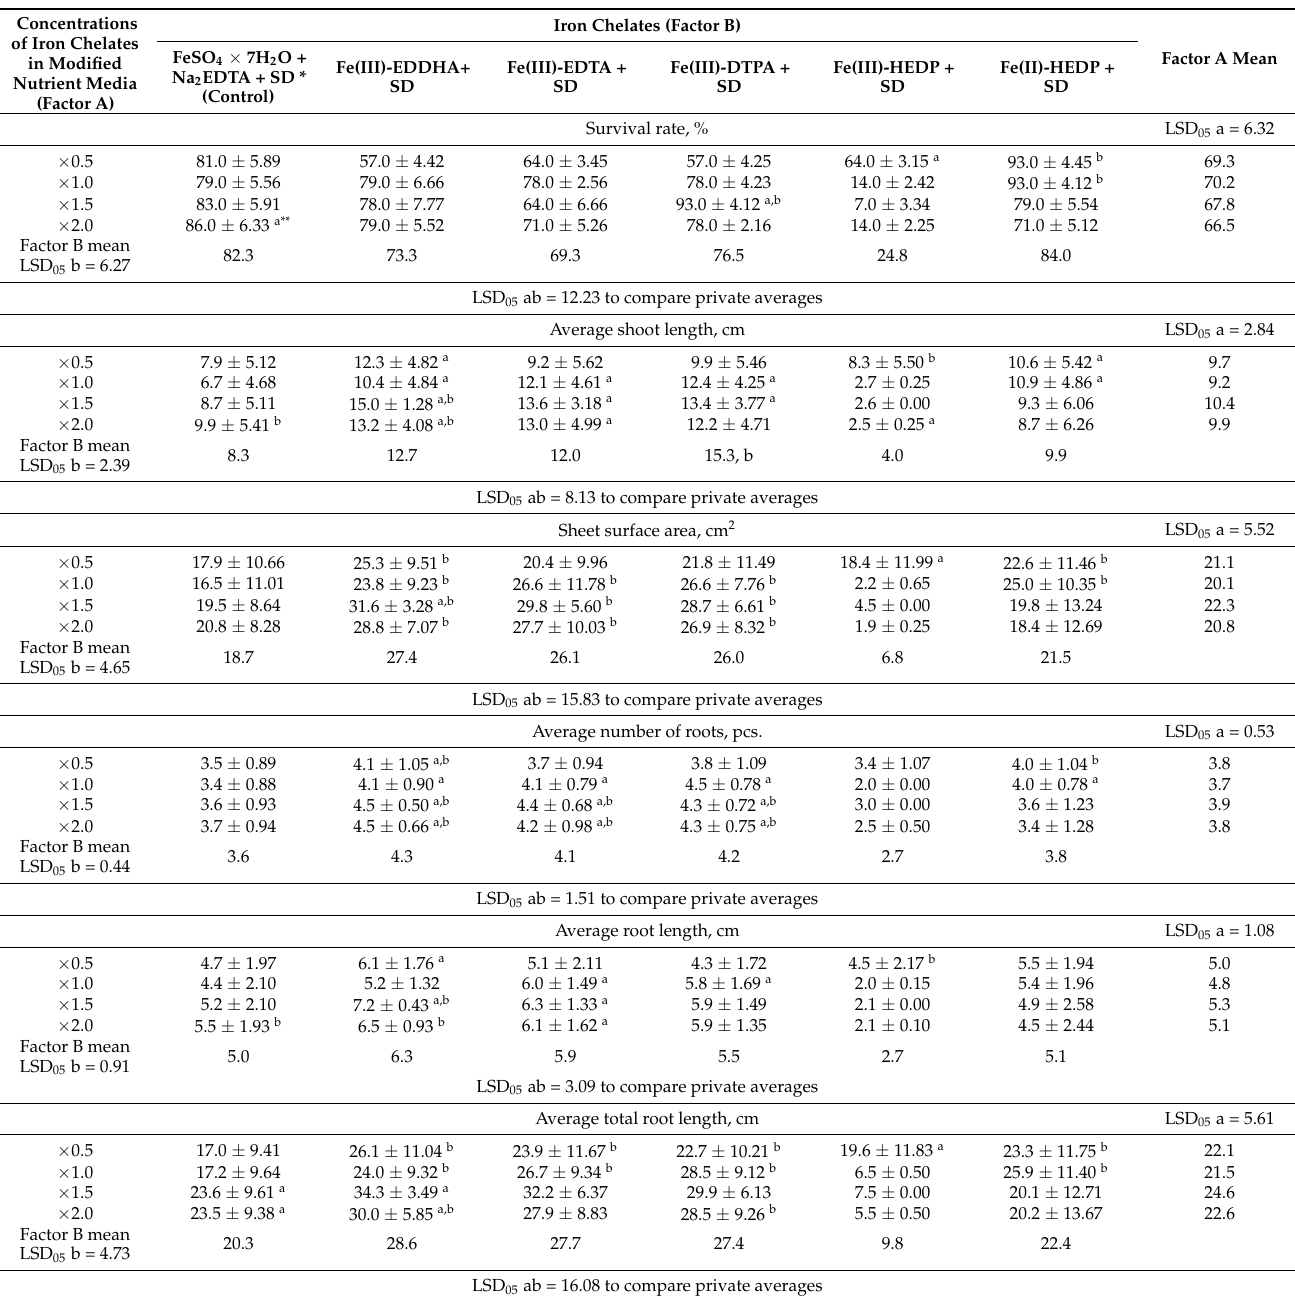
Table 4. The influence of the type of iron and its concentration in the nutrient medium on the morphometric parameters of blue honeysuckle “Lulia” ( Lonicera caerulea var. kamtschatica Sevast.) at the stage of growing plants in a